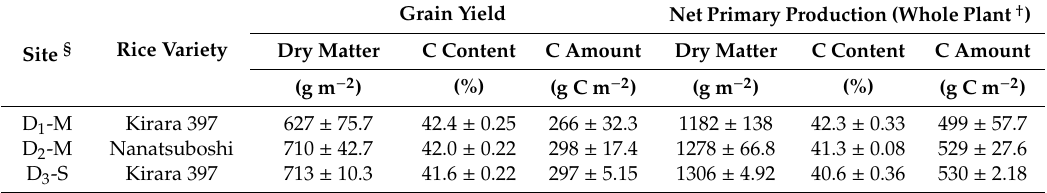
Table 4. Rice variety, net primary production (NPP) and grain yield of rice with their C